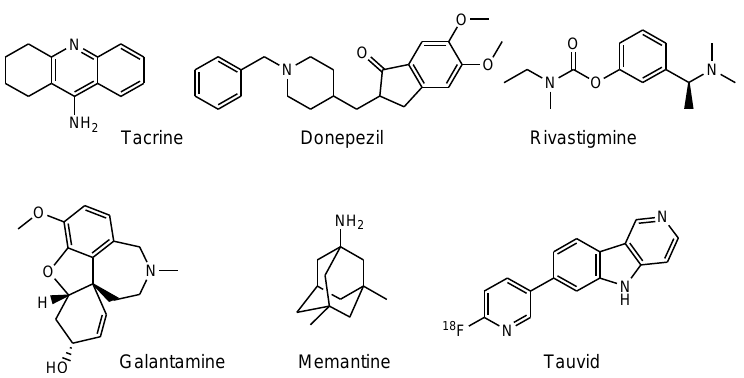
Figure 1. Structures of approved drugs and a tau imaging agent for Alzheimer’s disease. Drug membrane permeability is a serious problem that needs to be addressed in the field of drug discovery and development. The blood-brain barrier (BBB) prevents drugs that target the central nervous system (CNS) from entering the brain. The BBB consists of: